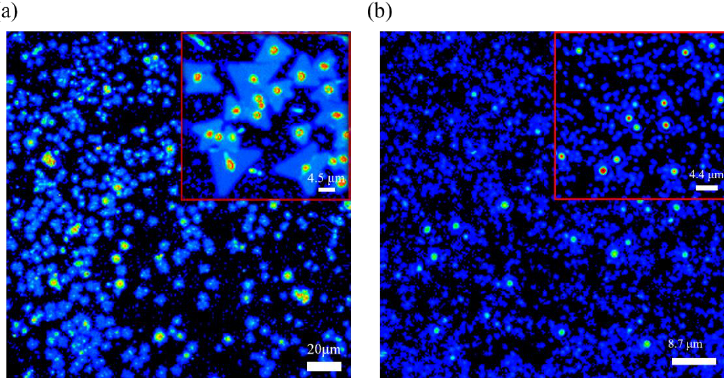
Figure 6. Multiphoton images of ( a ) MoS 2 /SiO 2 /Si and of ( b ) MoS 2 /Cu 2